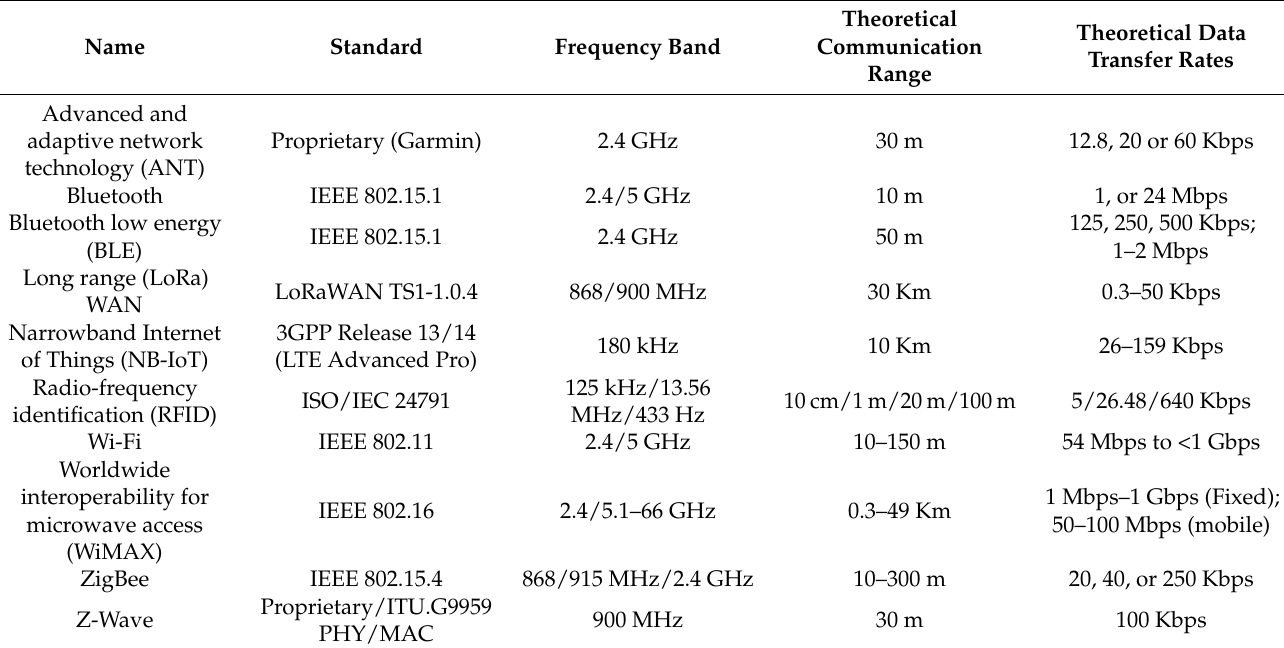
Table 1. Comparison of wireless communication technologies. Data from